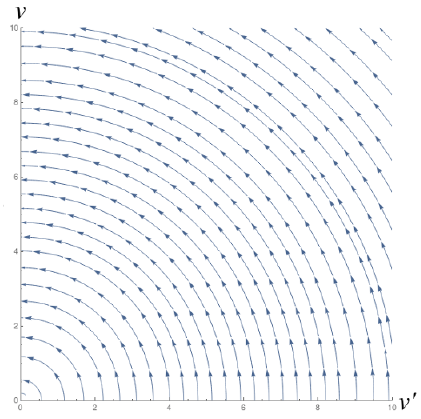
Figure 3 . Plot of (cid:0) Grad( V ) as a function of v and v 0 . The (cid:13)ow goes towards v 0 = 0, suggesting that the system, eventually, relaxes to a supersymmetry preserving vacuum at (cid:12)nite distance in (cid:12)eld